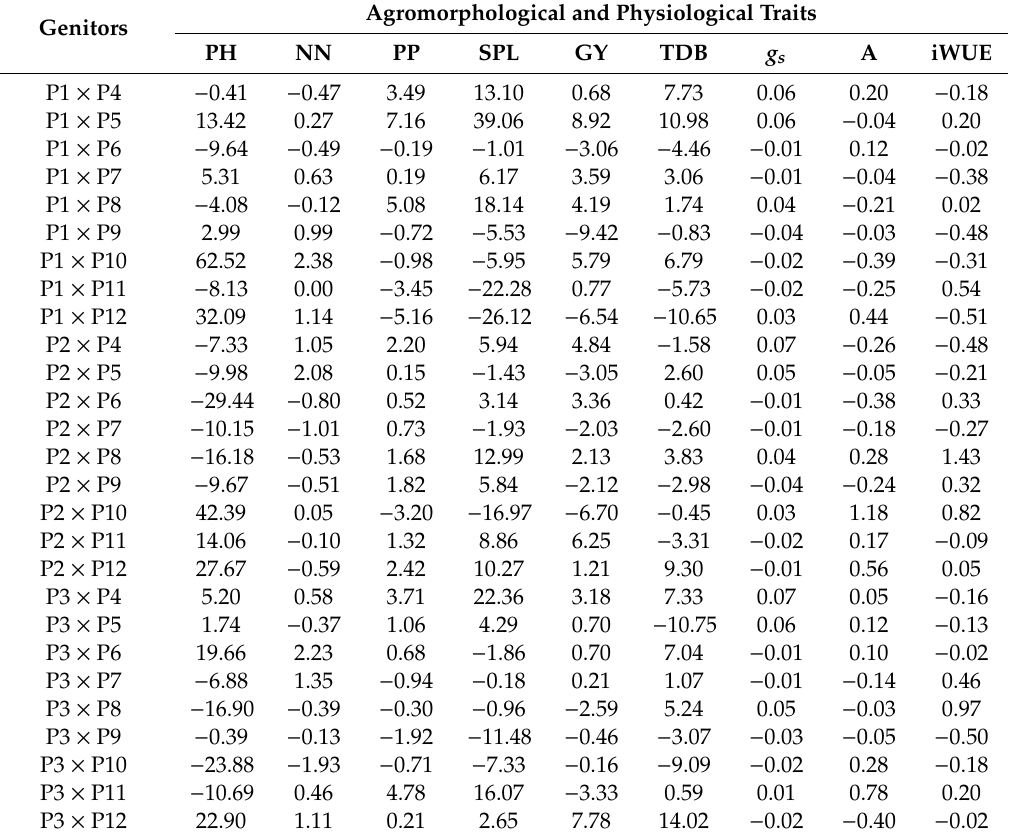
Table 6. Estimates of specific combining ability (ˆ s ij ) e ff ects resulting from the diallel crosses among the common bean genotypes cultivated under water